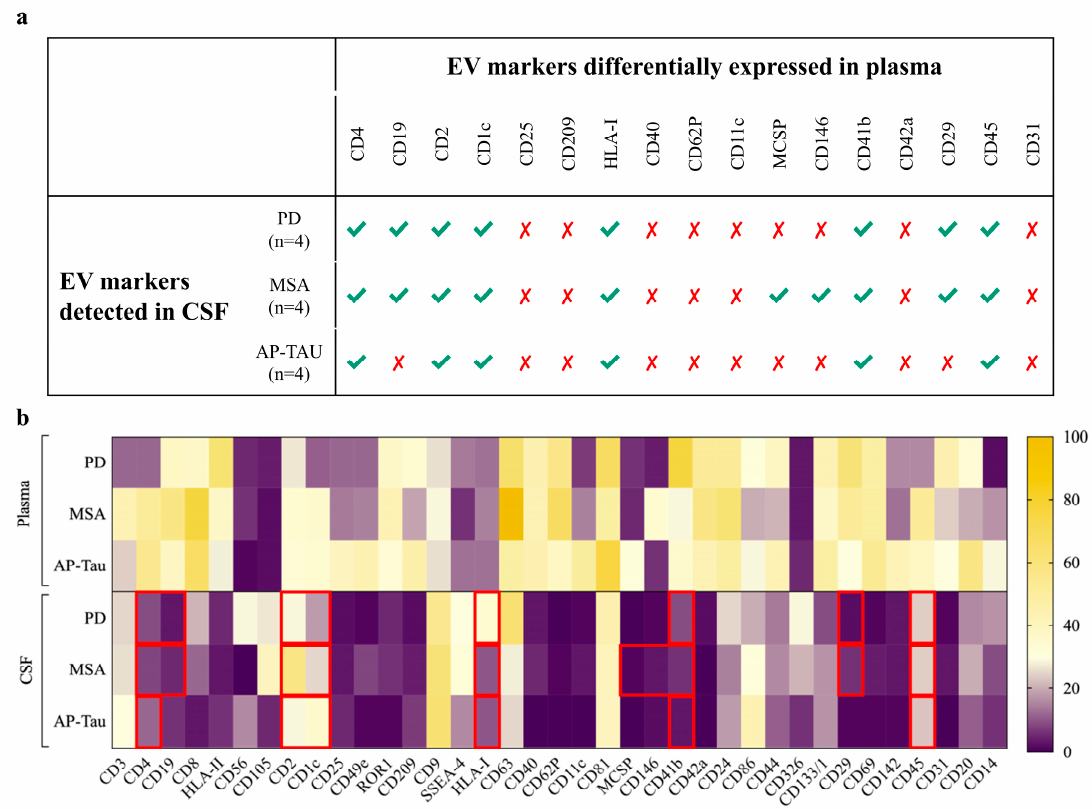
Figure 5. EV surface marker selection. Selection of extracellular vesicle (EV) surface markers for the 2-level random forest diagnostic model: ( a ) EV surface markers differentially expressed in plasma and detected in cerebrospinal fluid (CSF) of Parkinson’s disease (PD), multisystem atrophy (MSA), or atypical parkinsonism with tauopathies (AP-Tau). ( b ) Heatmap representation of the 37 EV surface markers in plasma and CSF of matched subjects with PD, MSA and AP-Tau. The selected markers in each diagnostic category were highlighted with red